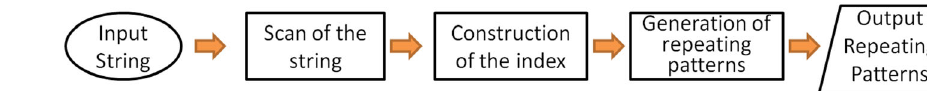
in biological cell DNA occur in multiple copies throughout a genome. The functions and descriptions of these sub- sequences are currently being characterized by